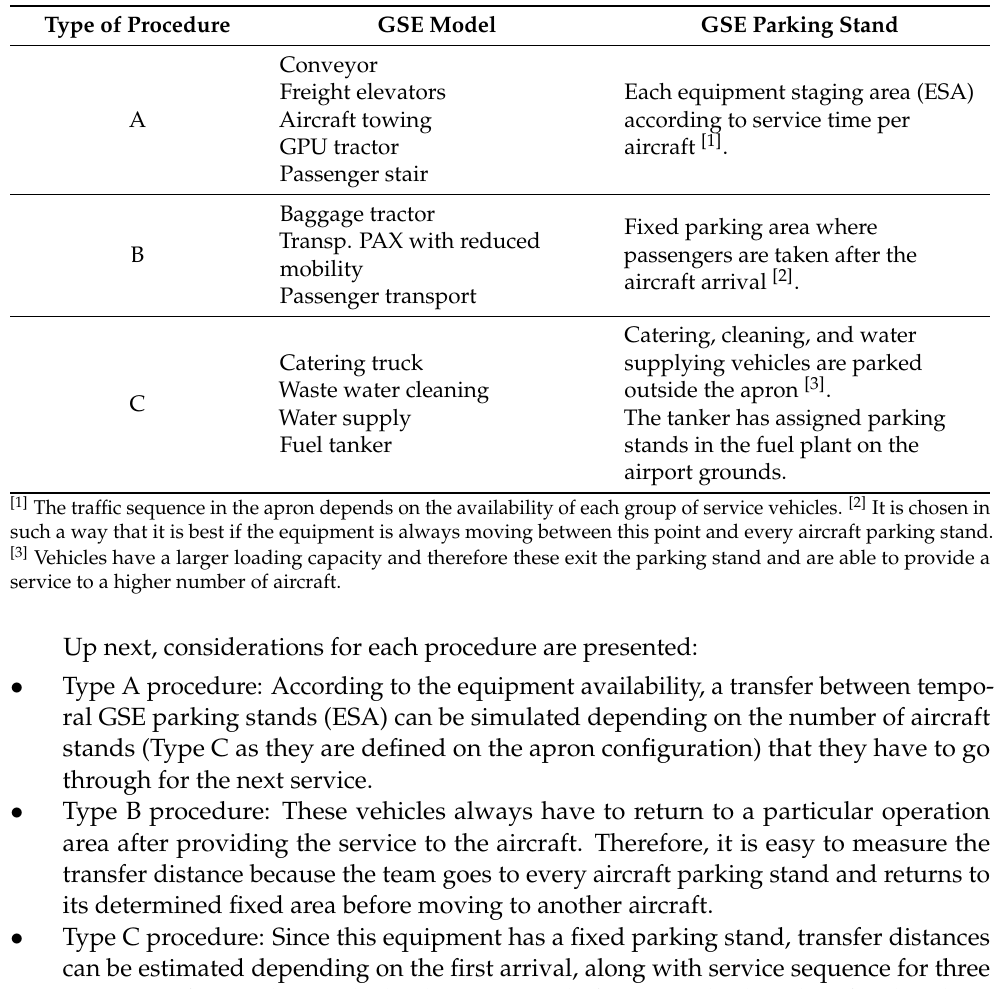
Table 3. Procedure type according to the parking stands of GSE